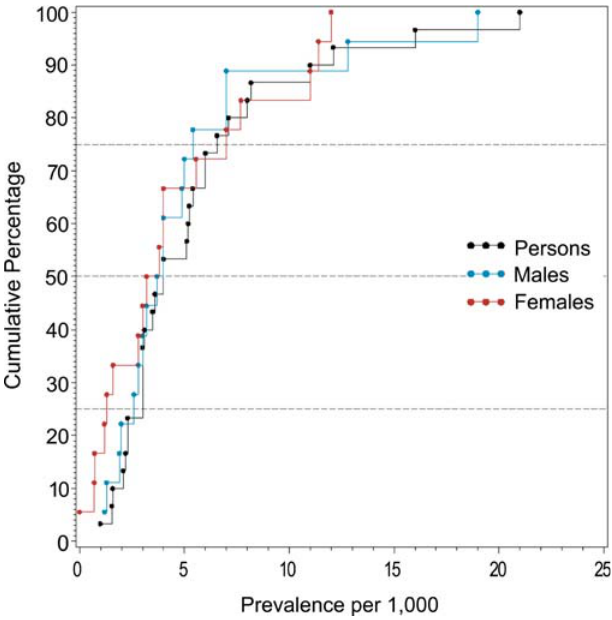
Figure 4. Cumulative Plots of the Lifetime Prevalence Estimates per 1,000 by Sex DOI: 10.1371/journal.pmed.0020141.g004